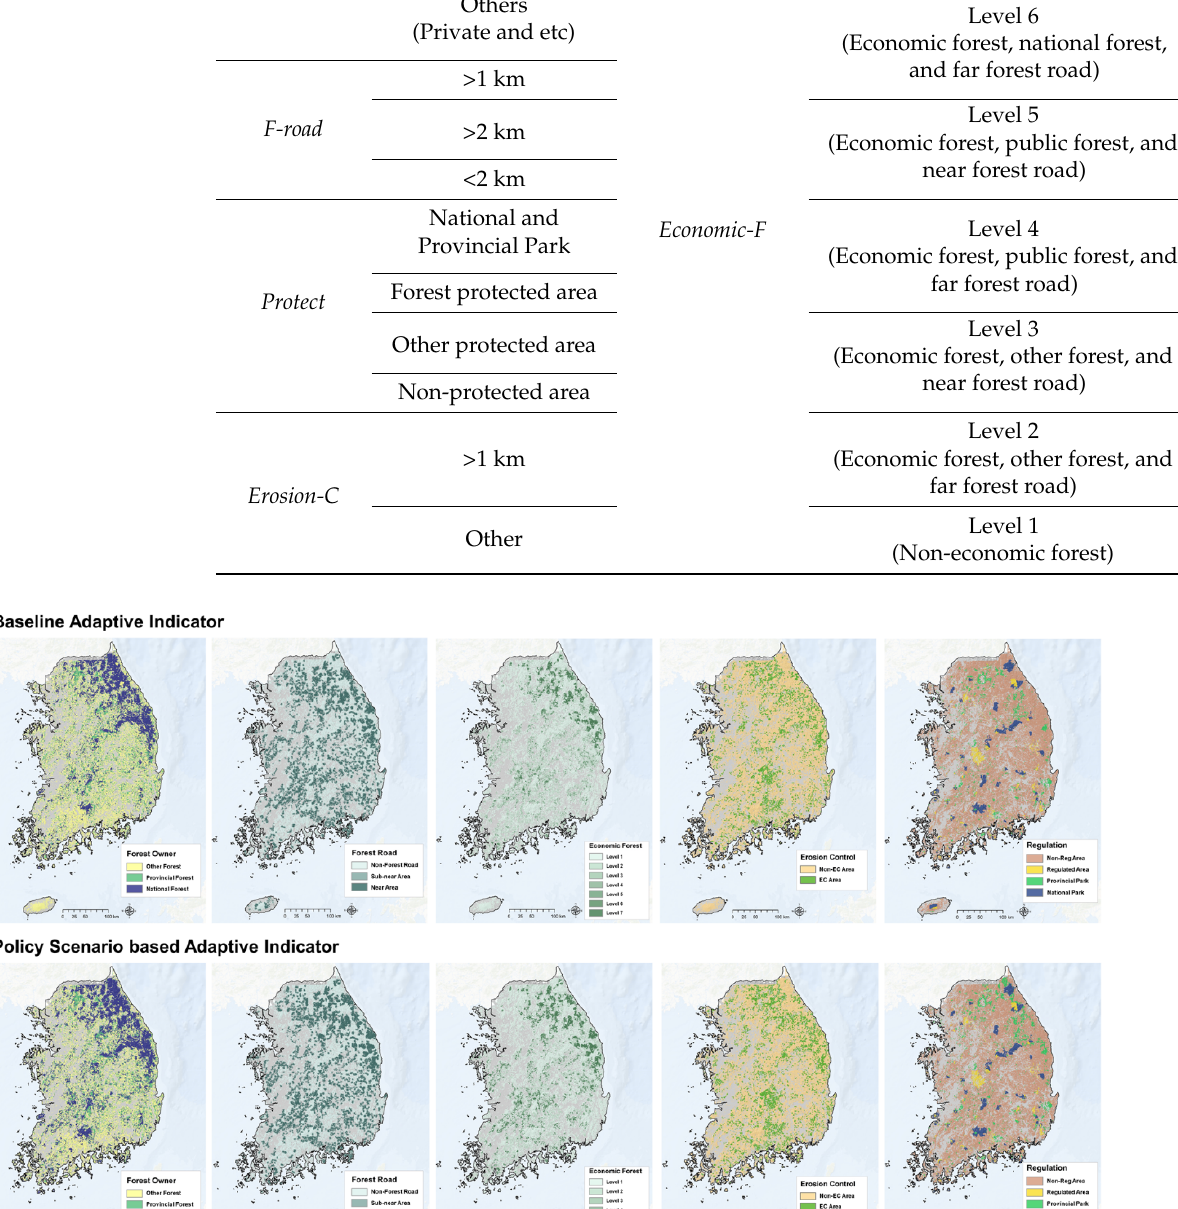
Figure 3. Maps of forest-related adaptive input variables for baseline and policy scenario.